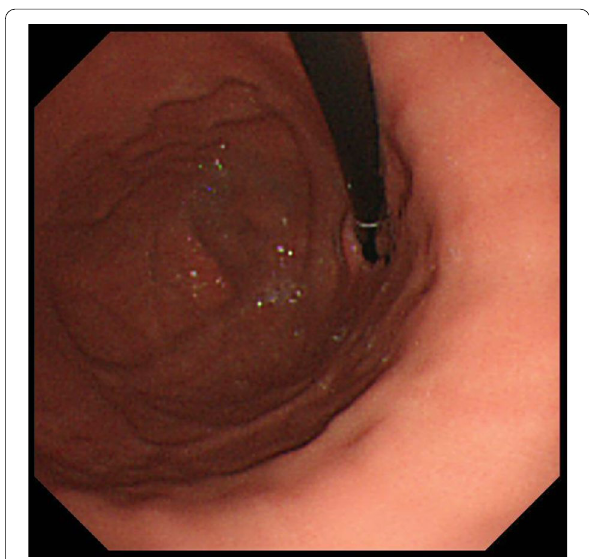
Fig. 3 Esophagoduodenoscopy. No gastric varices were identified as a source of bleeding